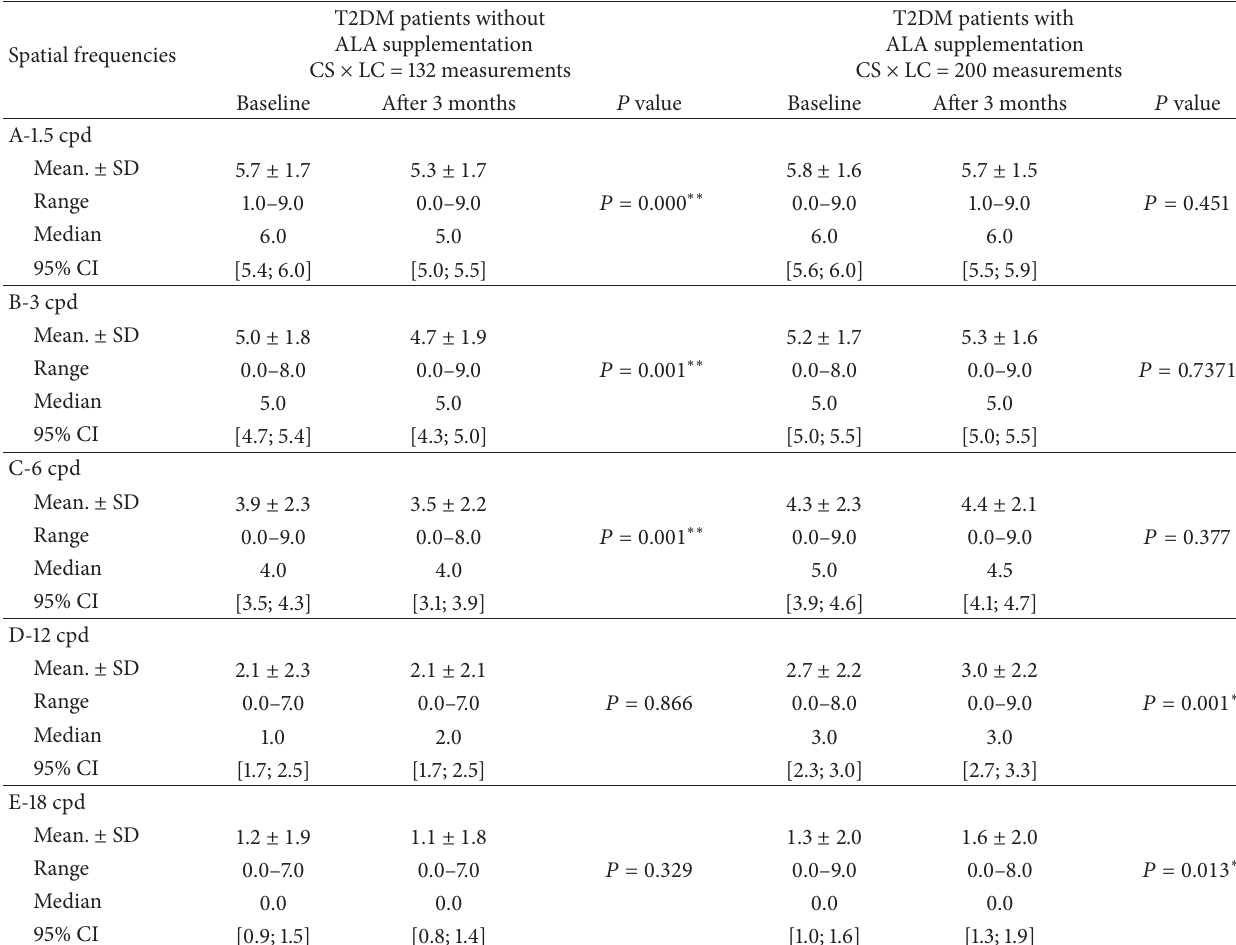
Table 3: Characteristics of contrast sensitivity examinations in T2DM patients with and without ALA supplementation at baseline and after 3